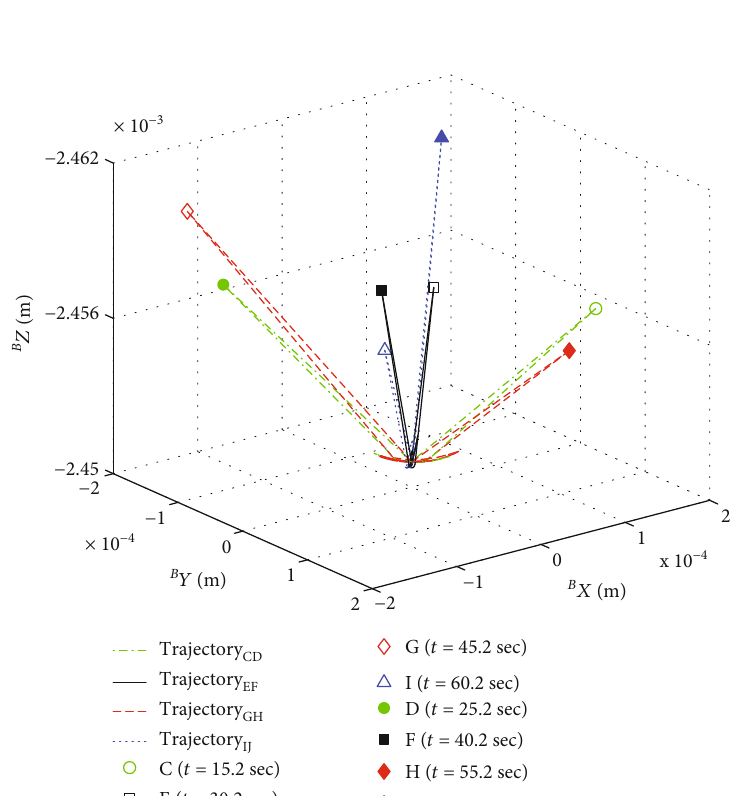
Figure 14: 3D position of the CG for the